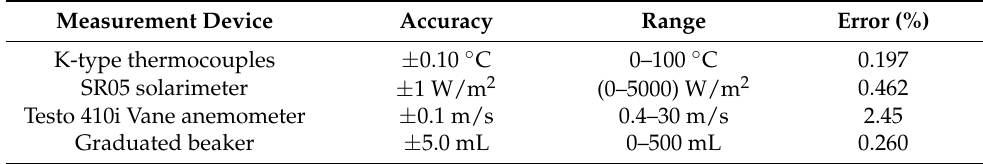
Table 1. Technical characteristics of measuring